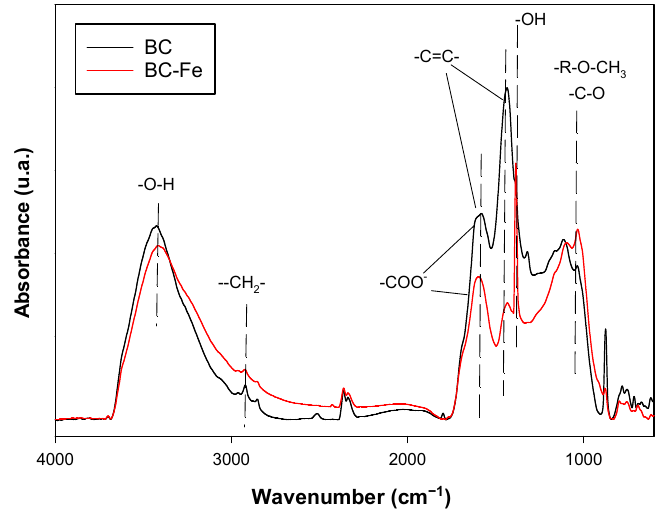
Figure 2. FTIR spectra for BC and BC-Fe indicating the most relevant bands recorded.